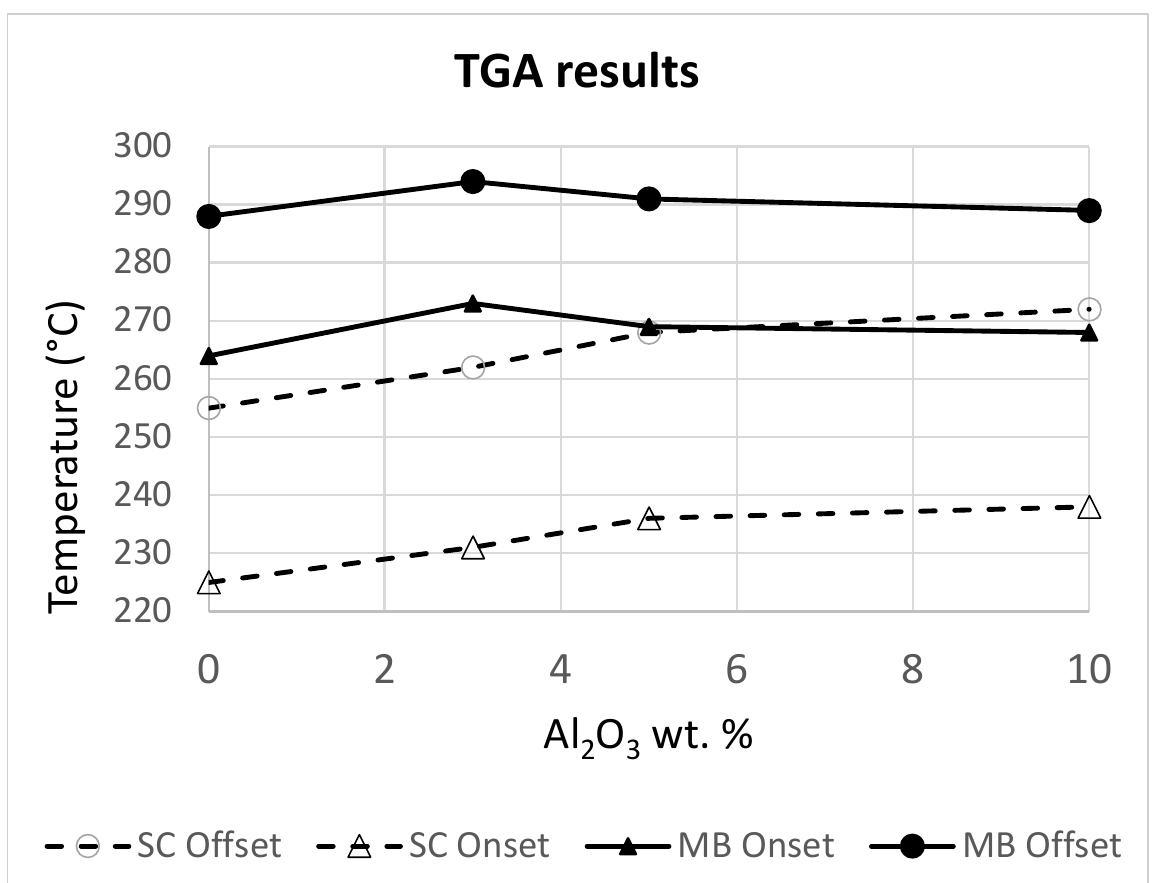
Figure 4. Results of the TGA measurements for the melt blended (MB) and solvent cast (SC) neat PHBH and its composites. The degradation onset and offset temperatures are shown.